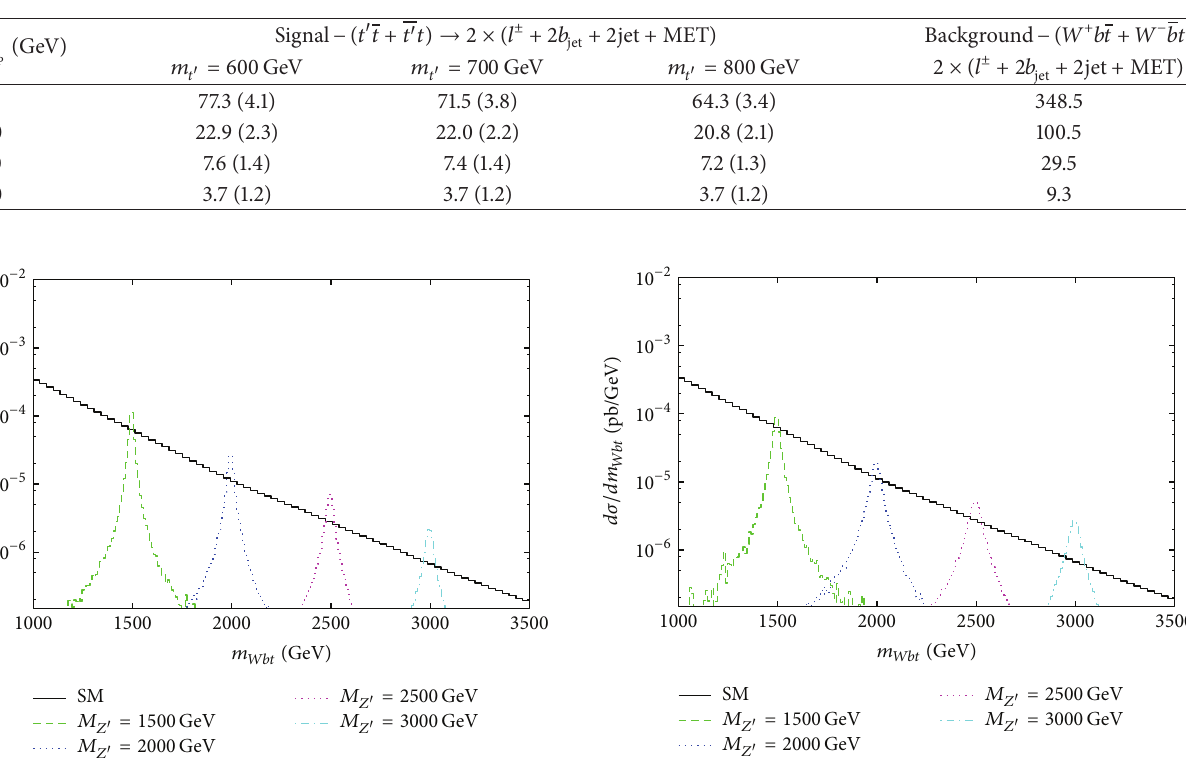
Figure 15: The same as Figure 13, but for 𝑍 󸀠 𝜒 model.